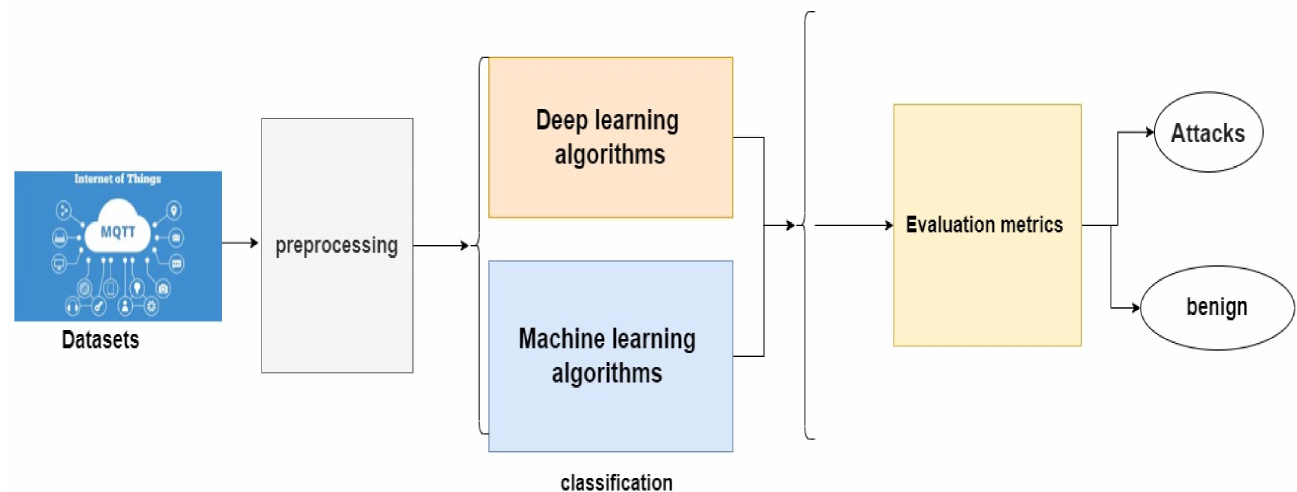
Figure 3. Proposed system for detecting MQTT